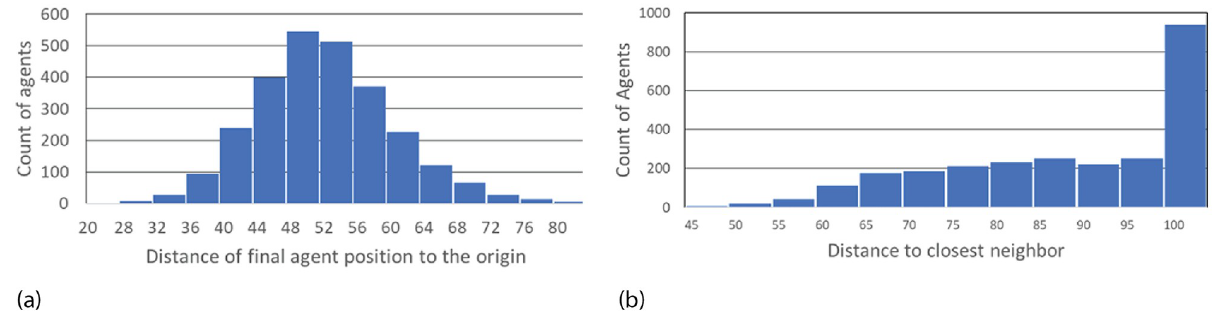
Fig 4. Distribution of agents at the end of 1000 simulations for AIB = 100, standard conditions. a) Distance from the origin. The mean distance is 52.6, about half of AIB = 100, and the SD 8.2; and b) MDCN = mean distance to closest neighbor. Median MDCN = 98.